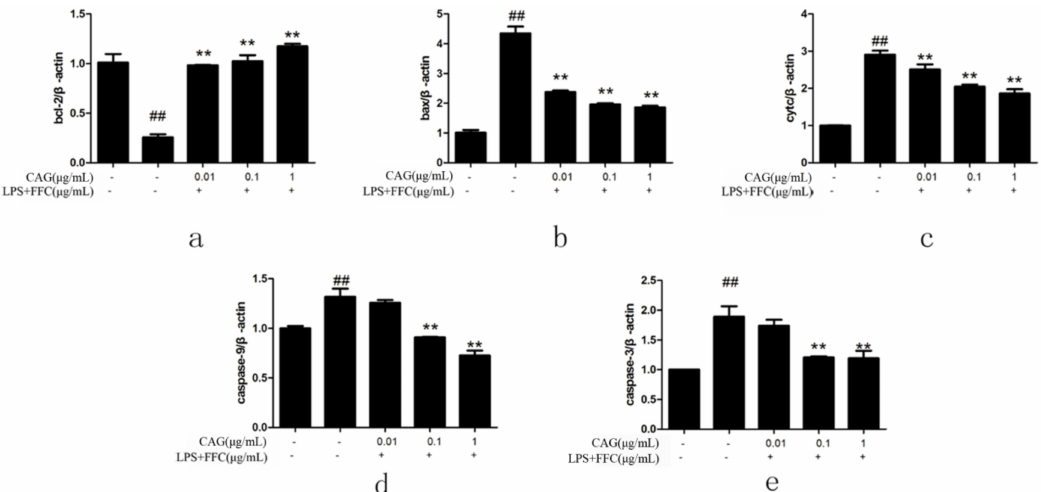
Figure 4. The mRNA expression of each group, β -actin was used as a reference. ( a ) bcl-2; ( b ) bax; ( c ) cytochrome c; ( d ) caspase-9; ( e ) caspase-3. The 2 − ∆∆ Ct method was used to quantify the expression levels of each gene. Values are expressed as the mean ± SD (n = 3). ## p < 0.01 compared to the control; ** p < 0.01 compared to the model.